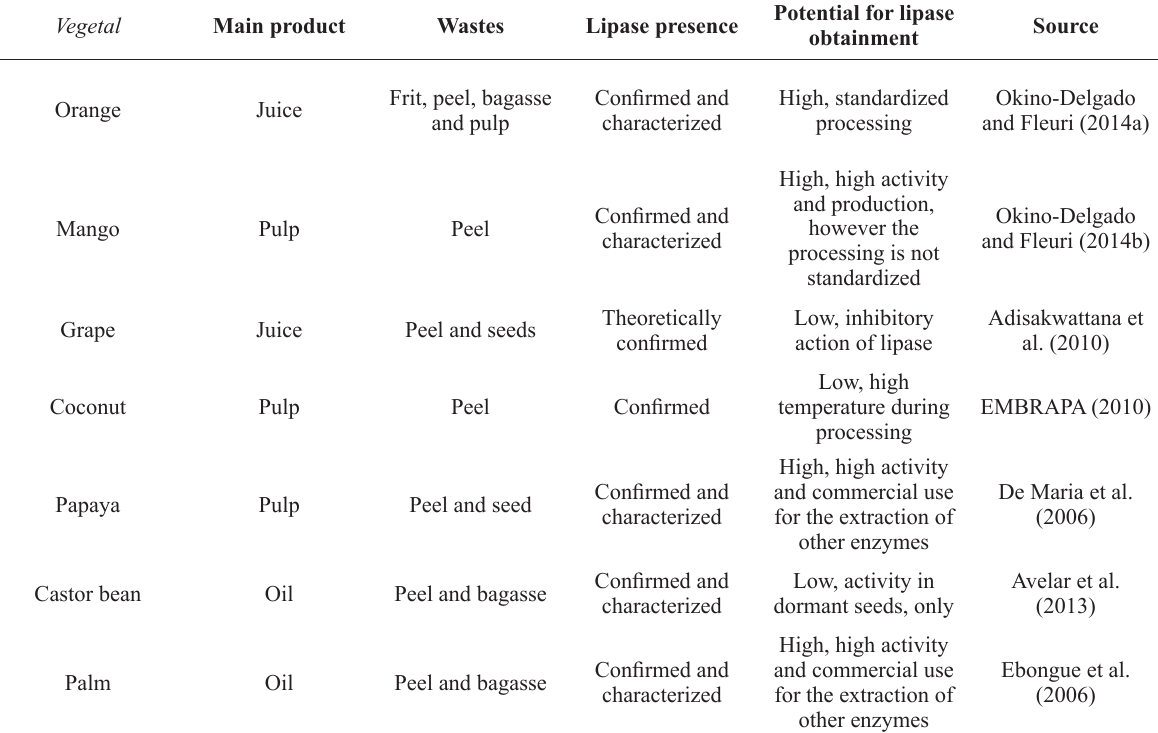
Potential of vegetal wastes for lipase